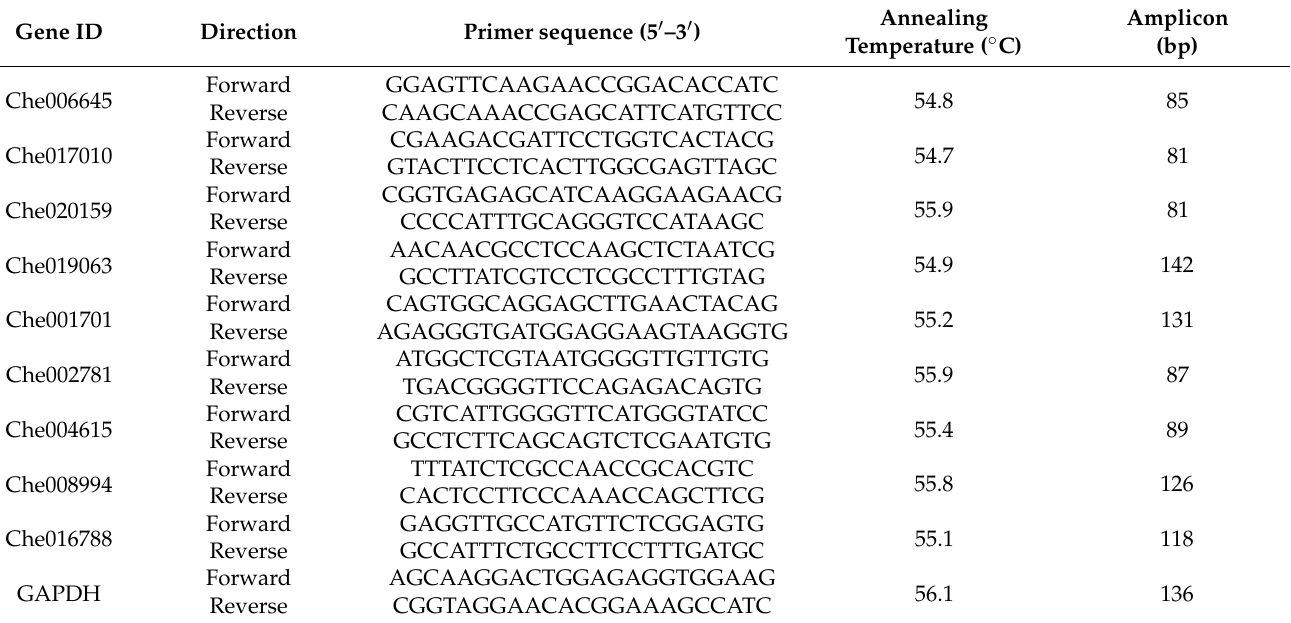
Figure 6. Venn diagrams of differentially expressed genes (DEGs) in different samples: ( a ) Venn diagram of all DEGs in different samples; ( b ) Venn diagram of up-regulated DEGs in different samples; ( c ) Venn diagram of down-regulated DEGs in different samples. Table 2. Details of oligonucleotide primers used for quantitative real-time polymerase chain reaction